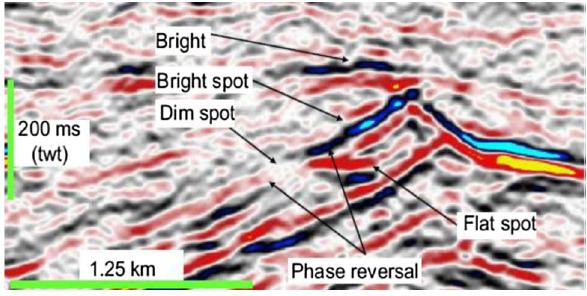
Fig. 5 3D PSTM seismic data on a base map (Perenco 2006)